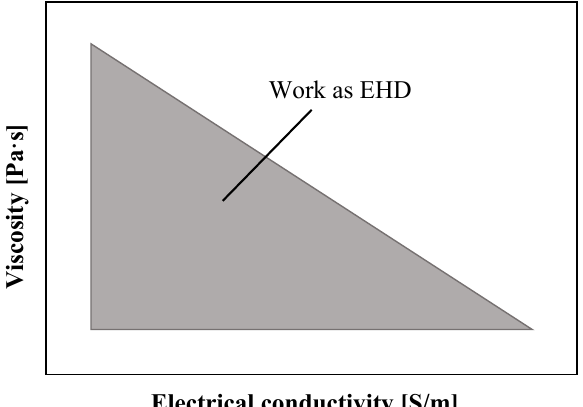
Figure 2. Distribution of working fluids in the electro-conjugate fluid triangle (log scale) [17]. The area inside the gray triangle is available for working fluids.